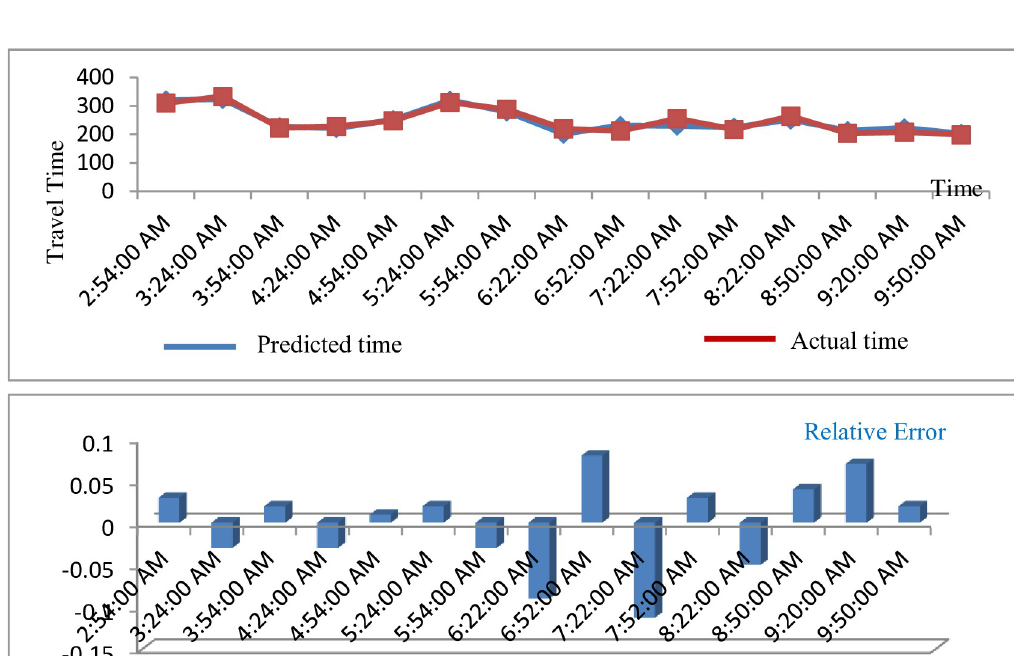
Fig 7. Predicted result of travel time (route segment